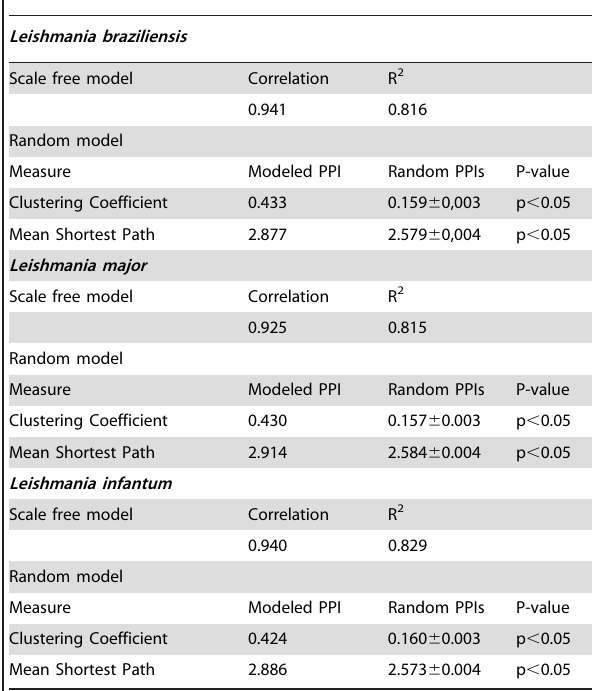
Table 3. Fitting results for scale-free model, and Clustering Coefficient and Mean Shortest Path for PPIs compared against the same measure extracted from 1000 Random